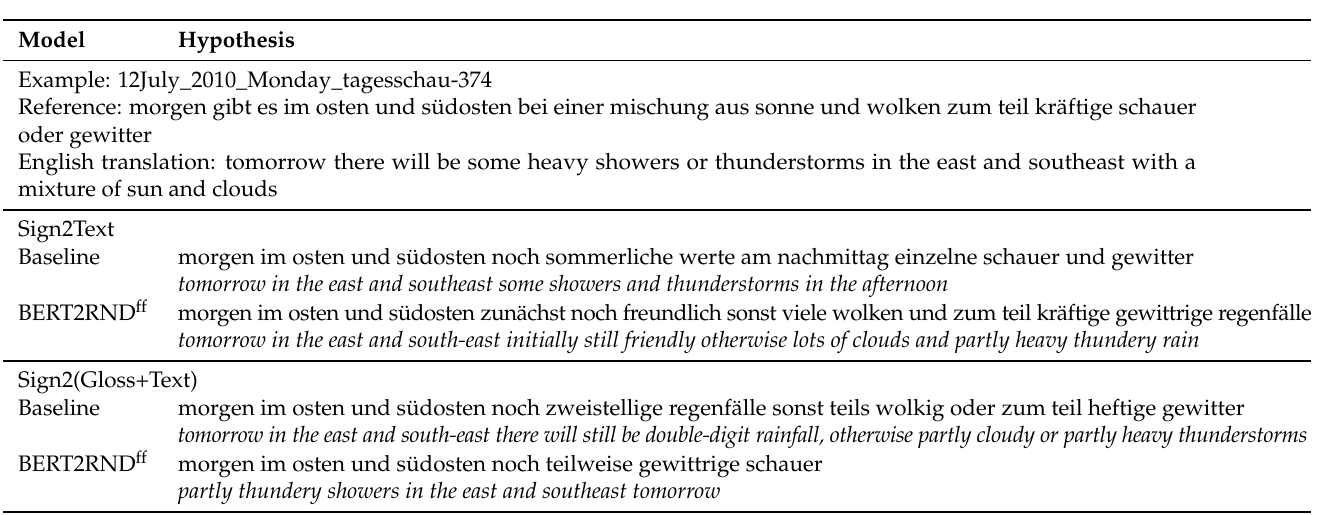
Table 4. Example hypotheses generated by the median BERT2RND ff model and the Baseline model. English translations are obtained using Google Translate (2 out of 3).